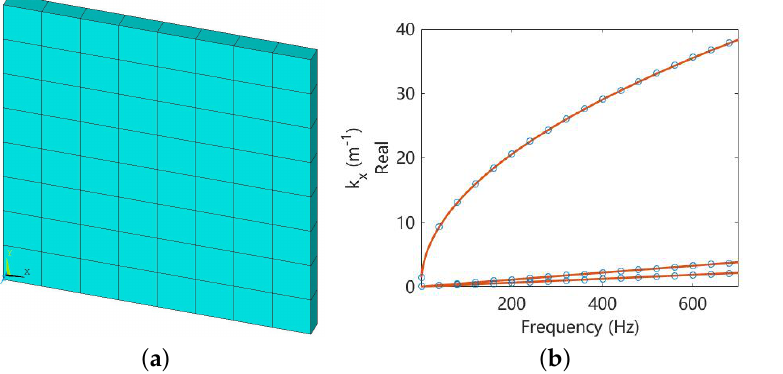
Figure 3. Unit cell model ( a ) and ( b ) the dispersion curves of the propagation waves long the x direction in the uniform host plate. The theoretical solutions are denoted by ◦ and the WFEM results are denoted by − . These are three curves, and they represent the longitudinal, torsional and flexural waves respectively. Note that in ( a ), the thickness of the shell element is